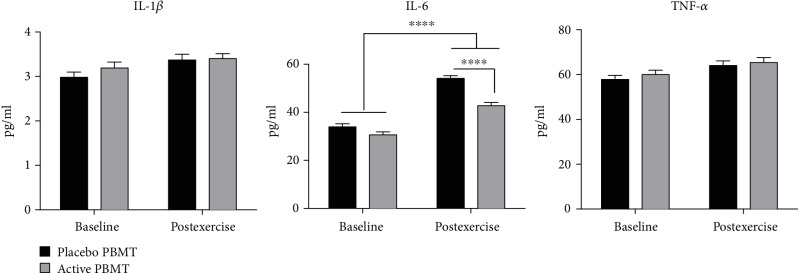
Levels of IL-1β, IL-6, and TNF-α. Data are expressed as mean and SEM. ∗∗∗∗p < 0.0001.